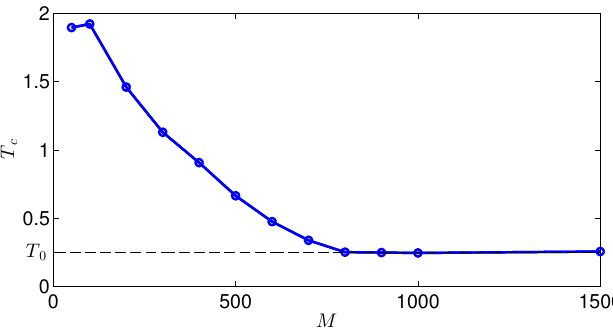
Figure 4. Critical transition times T increases. The dashed line corresponds to the exact delay T